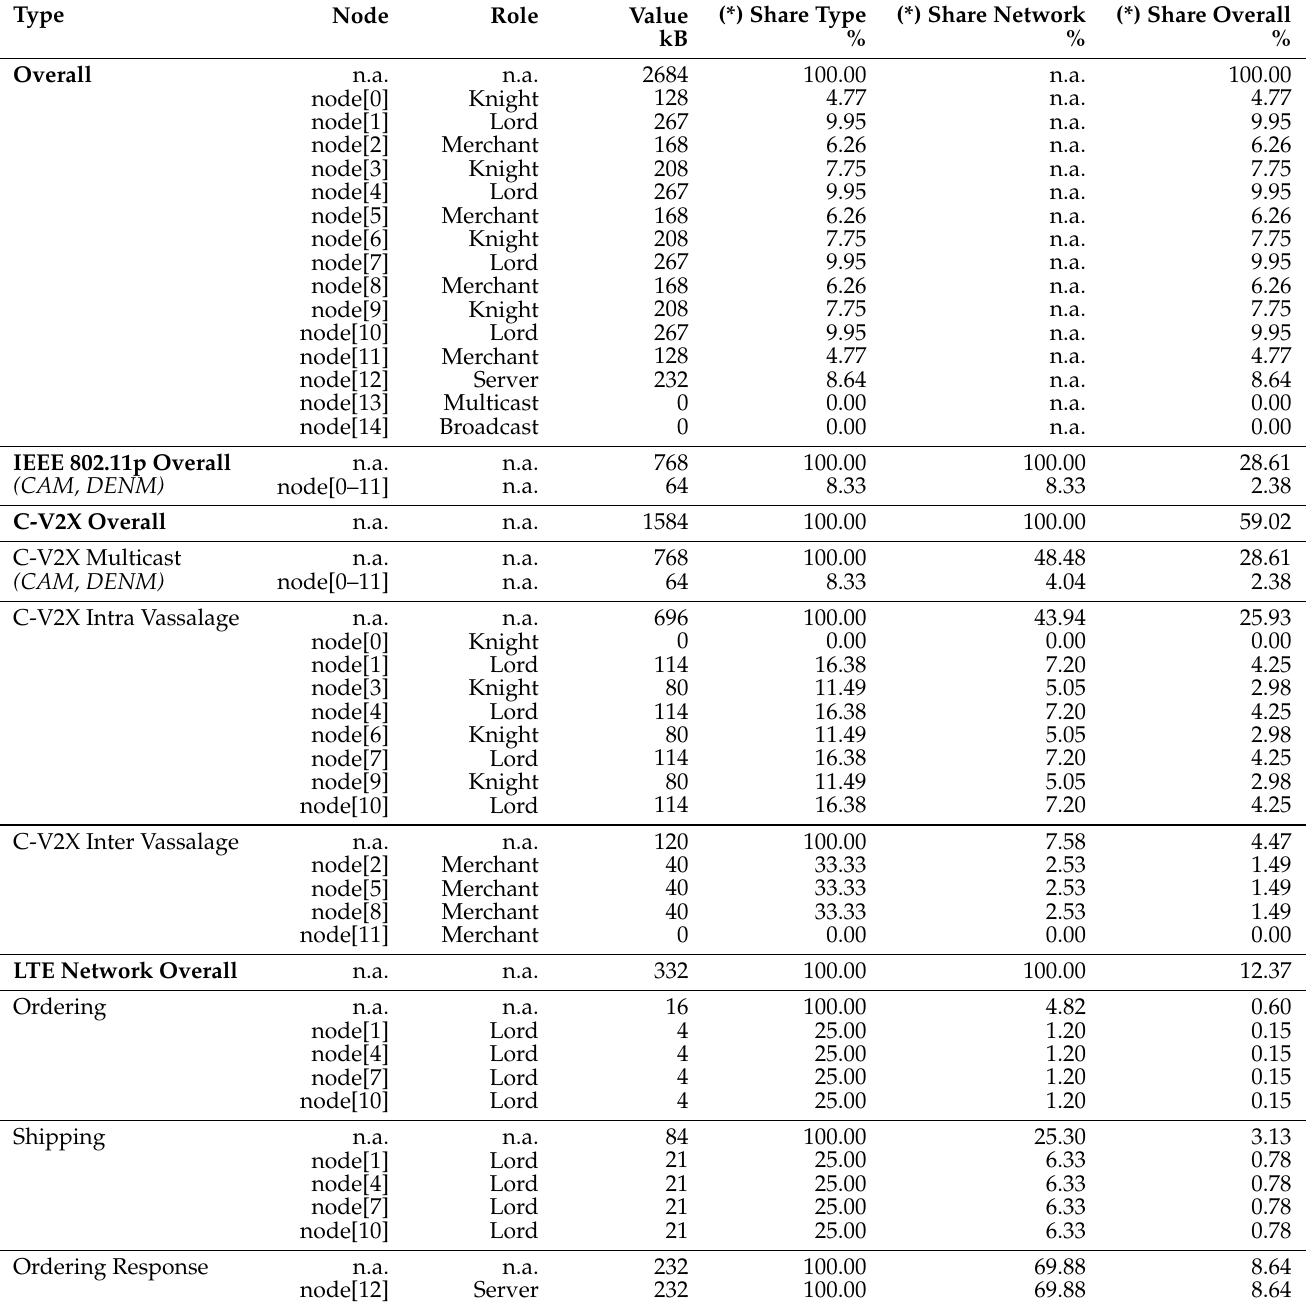
Table 2. Feudalistic Platooning : transmission shares per node and type of communication. The transferred data volume refers to a period of 300s. (*) Share values are rounded to two decimal places. Their sum results from the non-rounded values that may deviate